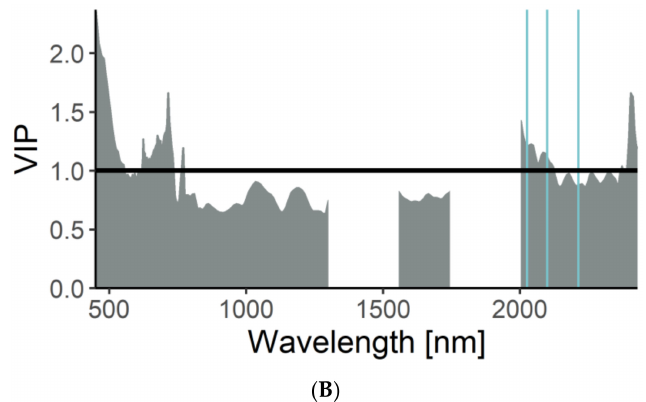
Figure 13. Measured against predicted soil organic carbon content (SOC) in the flight line of the hyperspectral Airborne Prism Experiment (APEX) sensor with a Cellulose Absorption Index (CAI) threshold at 0.75. The blue line is the 1:1 line, the red line is the regression line ( A ) with its variance importance in projection (VIP) scores ( B ). Predictors with VIP values greater than one (area above the horizontal line in the plot) were considered significant for the PLSR model. The blue vertical lines show the spectral wavelengths used for the CAI index.